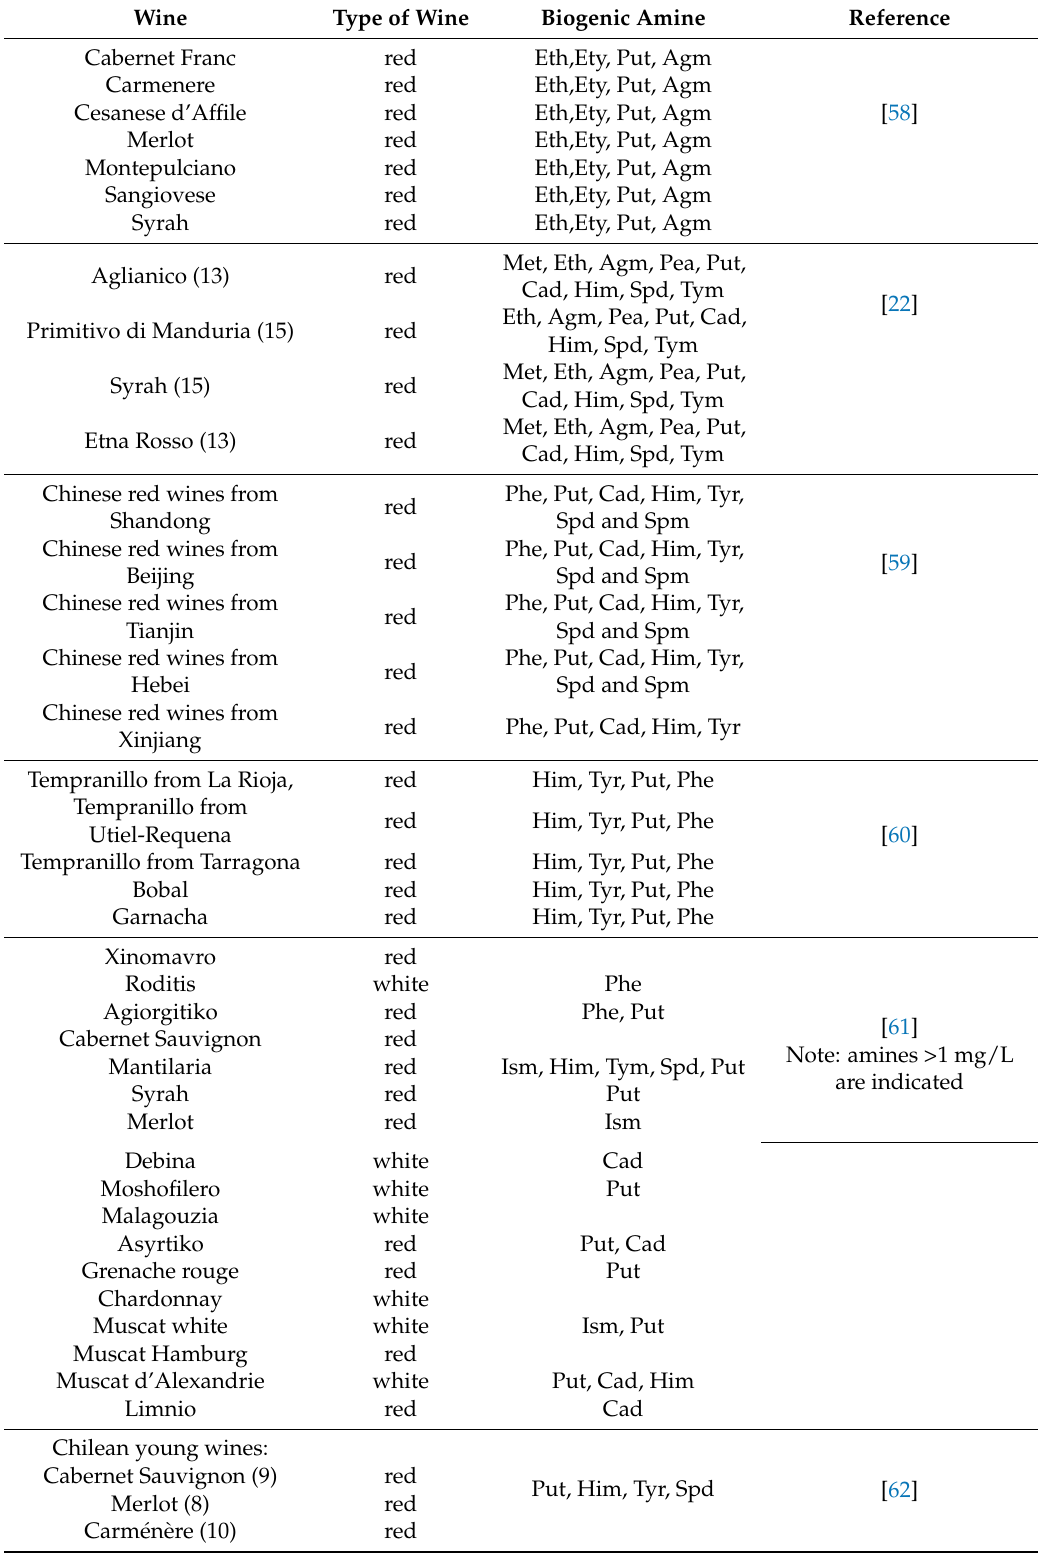
Table 1. Biogenic amines found in different grape and